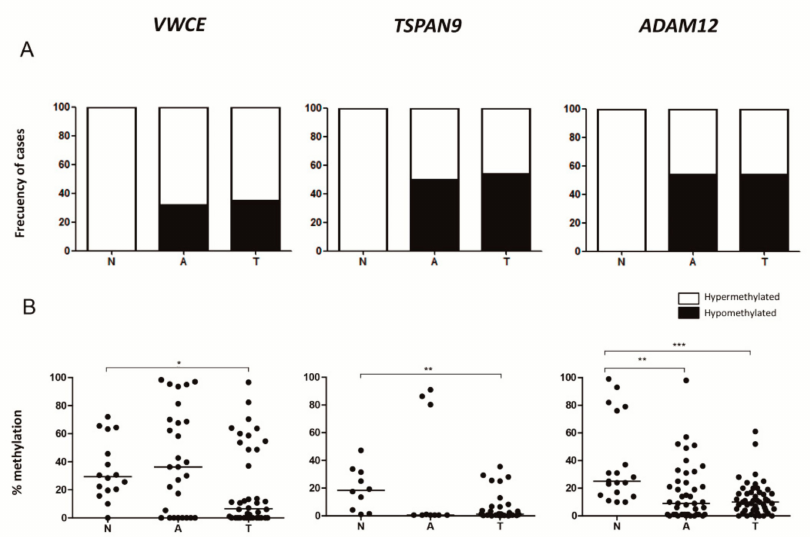
Figure 4. Methylation status of VWCE , TSPAN9 and ADAM12 genes in breast tissues. ( A ) Percentages of hypomethylated and hypermethylated cases are represented. Samples with methylation levels below the minimum percentage of methylation observed in our non-neoplastic tissue series are considered hypomethylated cases. ( B ) Mean methylation percentage of all the analysed CpGs in each gene was measured by pyrosequencing in non-neoplastic breast (N), adjacent-to-tumour (A) and TNBC (T) tissues. The horizontal lines represent the median of the series (*, p < 0.05; **, p < 0.01; ***, p <